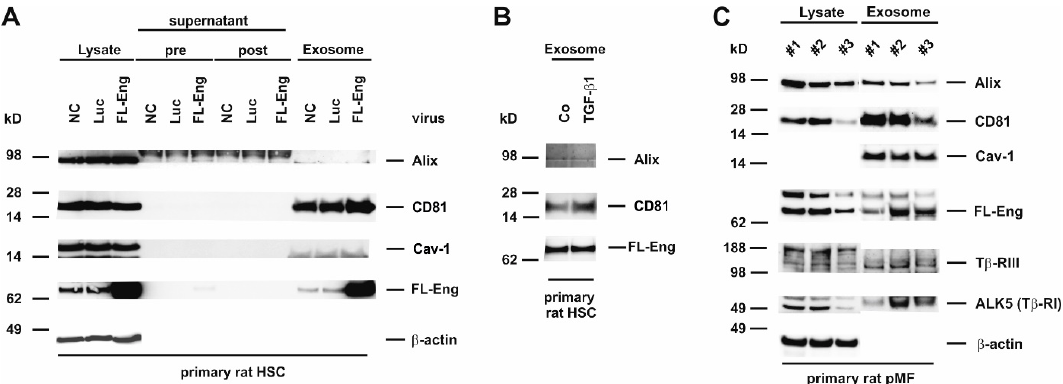
Figure 6. Identification of full-length Endoglin in primary mesenchymal liver cells. ( A ) Cell protein extracts, supernatant (pre), wash solution (post), and final exosome preparations from primary rat HSC untreated (NC), infected with adenoviral constructs expressing luciferase (Luc) or full-length endoglin (FL-Eng) were analysed by Western blot for expression of indicated proteins. ( B ) Primary rat HSC were stimulated or not with TGF- β 1 (1 ng/mL) for 24 h and exosomes were prepared. The corresponding proteins were analysed by Western blot for the expression of exosomal marker proteins and FL-Eng. ( C ) Cell lysates and corresponding exosomal proteins of three independent experiments of primary rat pMF were analysed by Western blot for exosomal markers and TGF- β -receptors. For displaying equal protein loading, the membrane was reprobed with a β -actin specific antibody. Note that in contrast to other liver cell lines and primary cells, rat pMF express significant amounts of T β -RIII and T β -RI in exosomes.